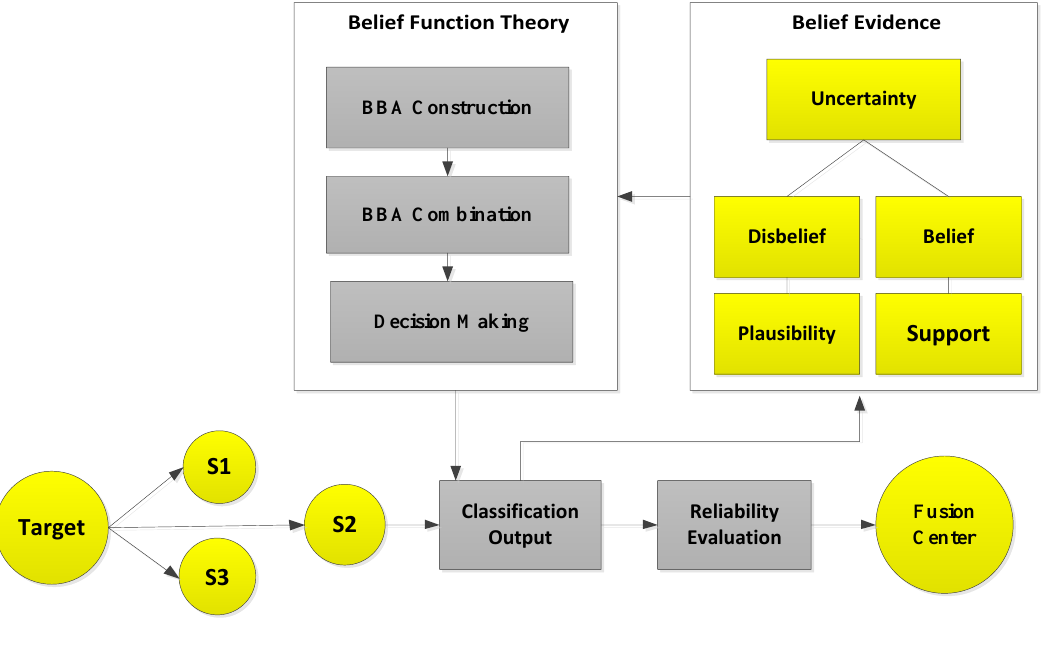
Figure 1. System model of belief function